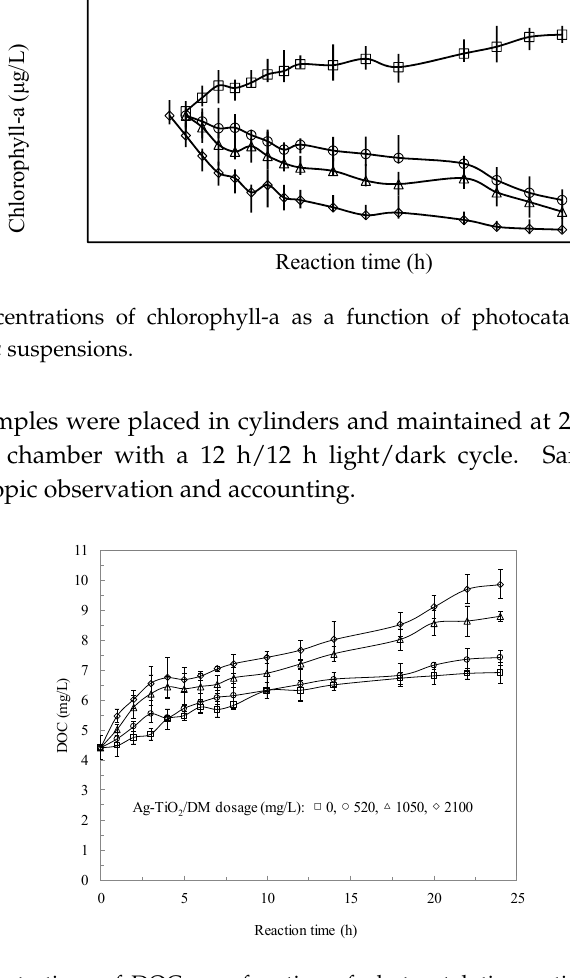
Figure 3. The concentrations of DOC as a function of photocatalytic reaction time in Microcystis aeruginosa suspensions.